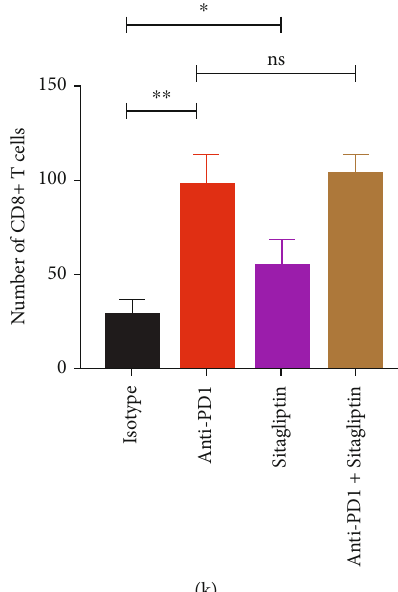
Figure 2: Sitagliptin shows di ff erent roles in di ff erent tumor models. (a) Schematic overview of experimental design combined for (b) – (k). (b – d) Tumor growth (b) and weight (c) from MC38 tumor-bearing C57BL/6 mice were shown ( n = 7 ). (e – g) Tumor growth (e) and weight (g) from CT26 tumor-bearing on BABL/C mice were shown ( n = 7 ). (h and i) Sections from MC38 subcutaneous tumors were stained with anti-CD8 antibody by immunohistochemistry (h), and CD8 + T cells in fi ltration were analyzed in (i). (j and k) Sections from CT26 subcutaneous tumors were stained with anti-CD8 antibody by immunohistochemistry (j), and CD8 + T cells in fi ltration were analyzed in (k). Scale bars: 100 μ m. Data were analyzed by two-way ANOVA (b and e) and t -test (c, f, i, and k). ns: no signi fi cance; ∗ p < 0 : 05 , ∗∗ p < 0 : 01 , and ∗∗∗ p < 0 : 001 . Error bars denote for the